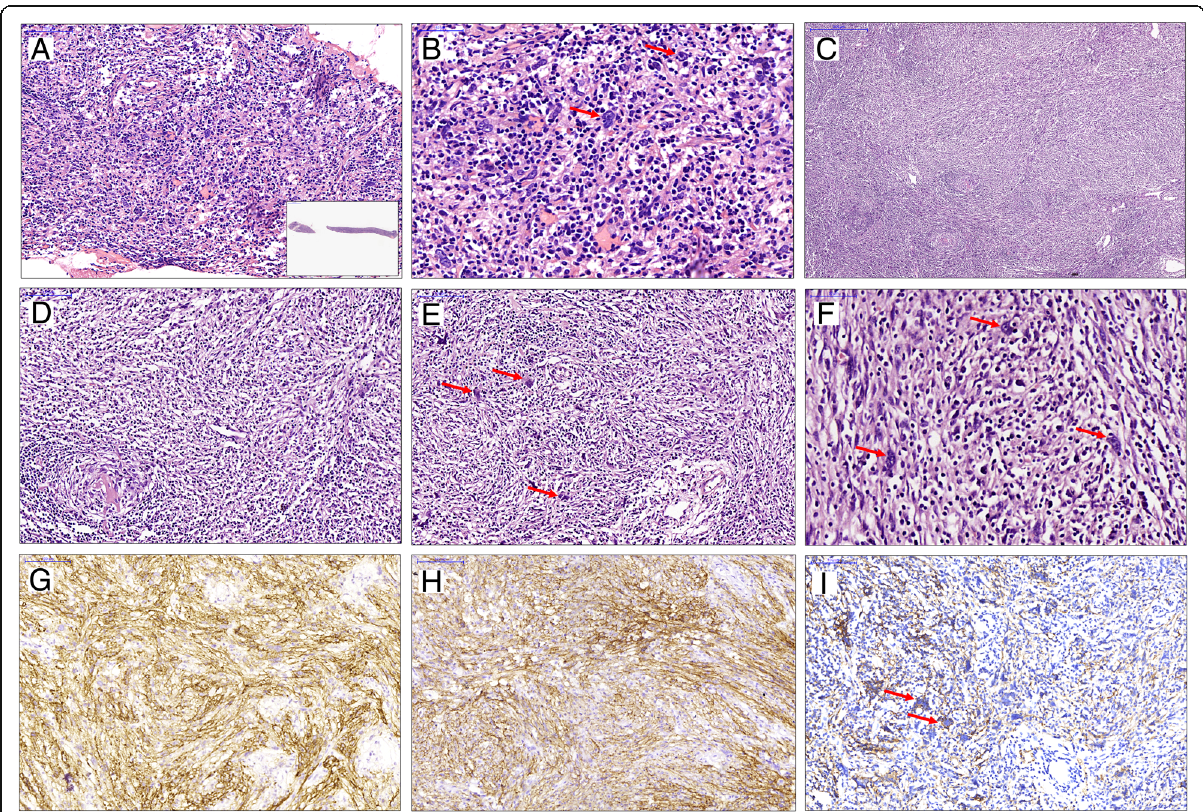
Fig. 2 Case 1: HE staining of core needle biopsy specimen shows there are a few large round or ovoid cells scattered in the inflammatory background ( a , inset: low-power view of needle biopsy), which are reminiscent of Hodgkin and Reed-Sternberg cells ( b , arrows). Microscopic examination of resected specimens exhibit the classical morphology of hyaline-vascular Castleman ’ s disease ( c , lower left area) and hyperplastic ovoid to spindle cells ( c , upper right area). High-power view of figure C shows the transitional zones ( d ). Multinucleated giant cells and Hodgkin and Reed-Sternberg-like cells are disseminated in the lesions ( e , f , arrows). Immunohistochemical staining shows the spindle cells (including some scattered large cells) are positive for CD21 ( g ), CD35 ( h ) and D2 – 40 ( i ,